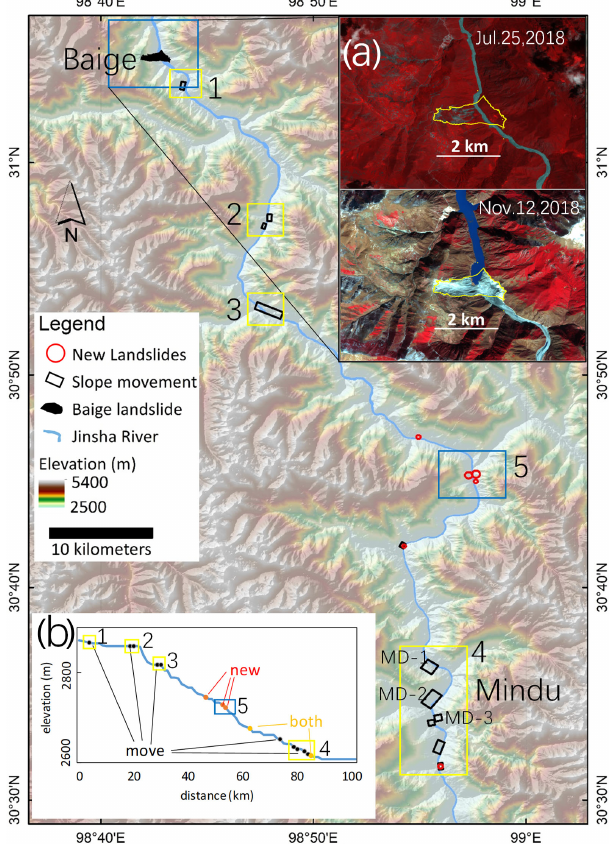
Figure 1. Map of the Jinsha River study region. The black rectan- gles are moving slopes detected after the Baige floods. The red cir- cles are new landslides after the floods. The yellow rectangles with black numbers 1 to 4 are map extents shown in Fig. 3a–d. The blue rectangles with the black number 5 show the map extent for Fig. 7. (a) Two Sentinel-2 images were taken before the Baige landslide in July 2018 (top) and after in November 2018 (bottom). (b) Lon- gitudinal profile of the Jinsha River in this section from the ALOS World 3D-30m DEM; the localities of new landslides and moving slopes are marked. The Jinsha River is digitized by the authors from Sentinel-2 images before the 2018